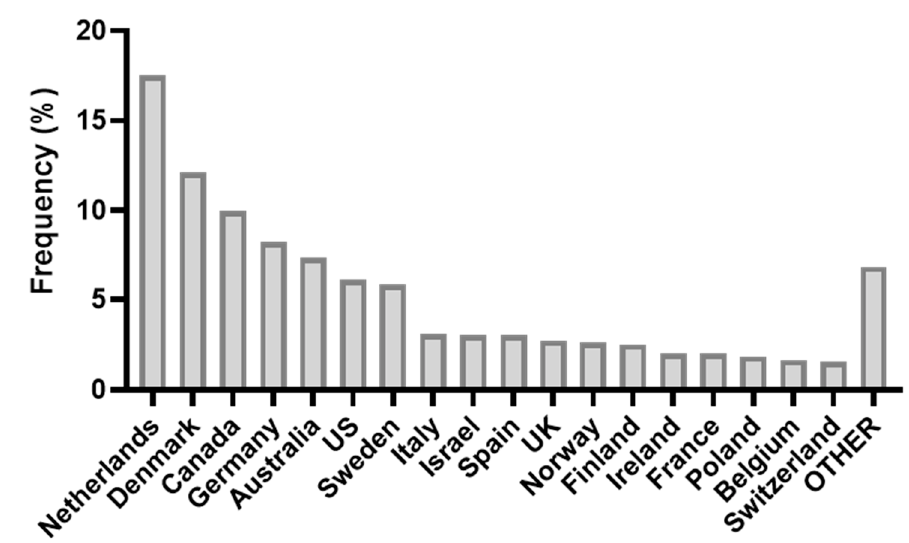
Figure 2. Papers: geographical distribution of authors’ affiliations.